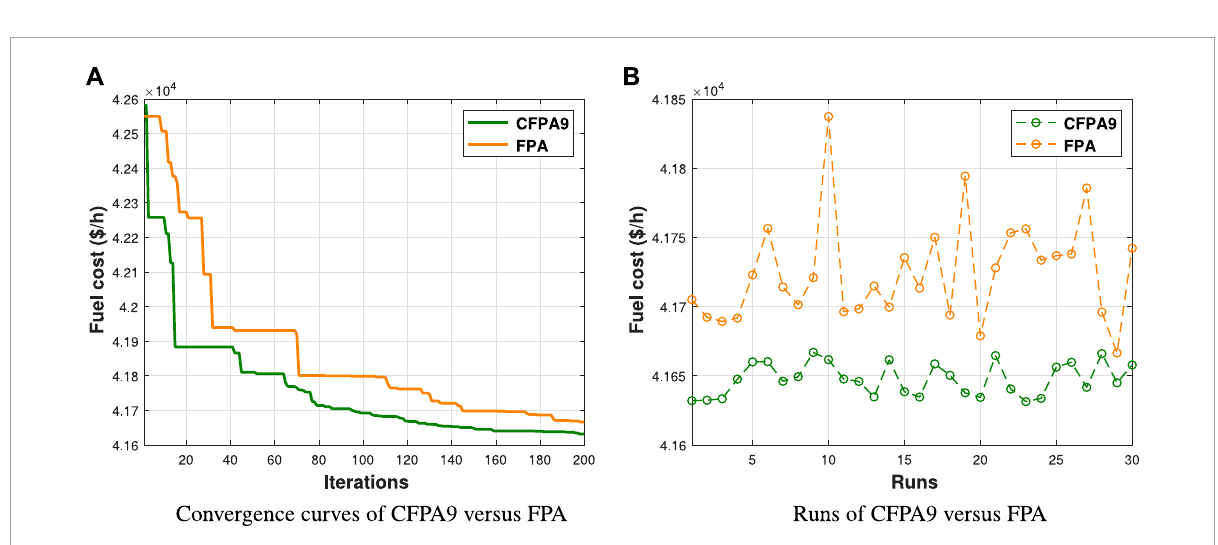
FIGURE 10 Fuel cost convergence and runs for FPA vs. CFPA9 for case 3. (A) Convergence curves of CFPA9 versus FPA and (B) runs of CFPA9 versus FPA.